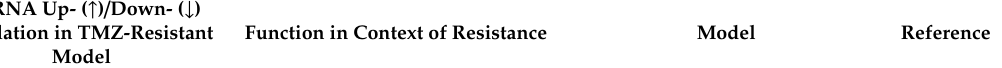
Table 1. Most common and less common lncRNAs that are involved in TMZ-resistance. lncRNA Up- ( ↑ ) / Down- ( ↓ ) Regulation in TMZ-Resistant Function in Context of Resistance Model